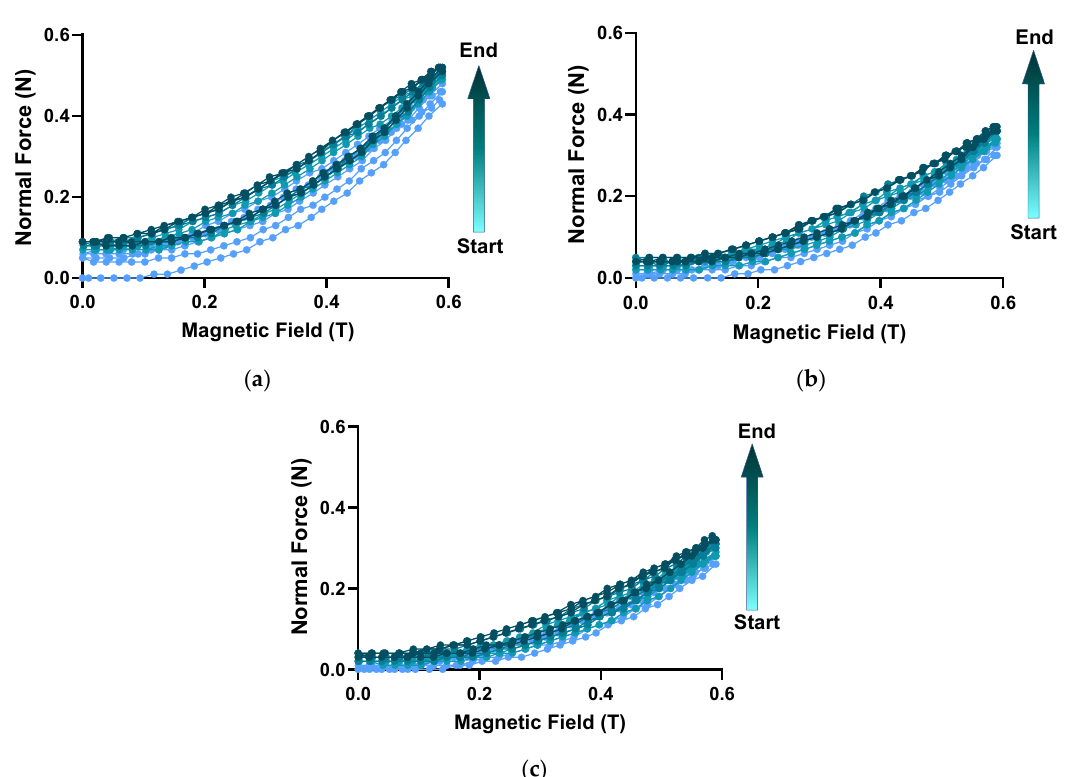
Figure 5. Comparison of normal force at shear strain of ( a ) 0.01%, ( b ) 0.1% and ( c ) 1% versus the magnetic field.